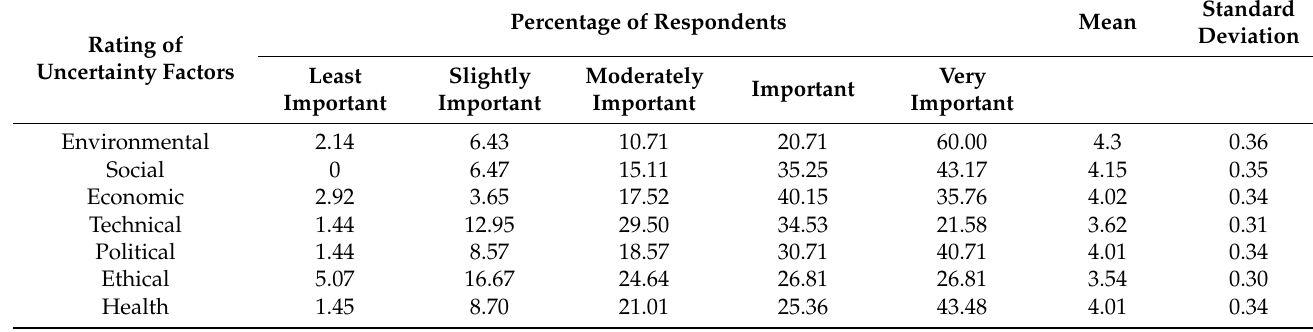
Table 3. Relevance of selected uncertainty factors.